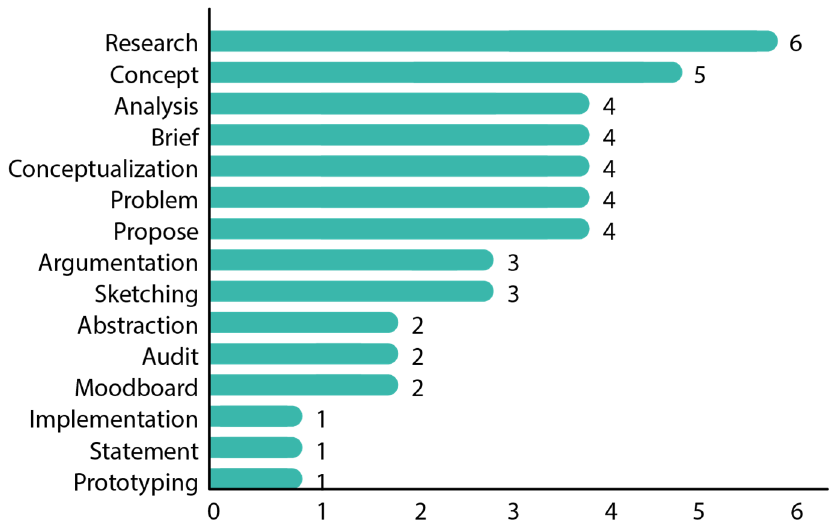
Figure 4. Exploratory analysis of concepts mentioned by interviewers (own elaboration).